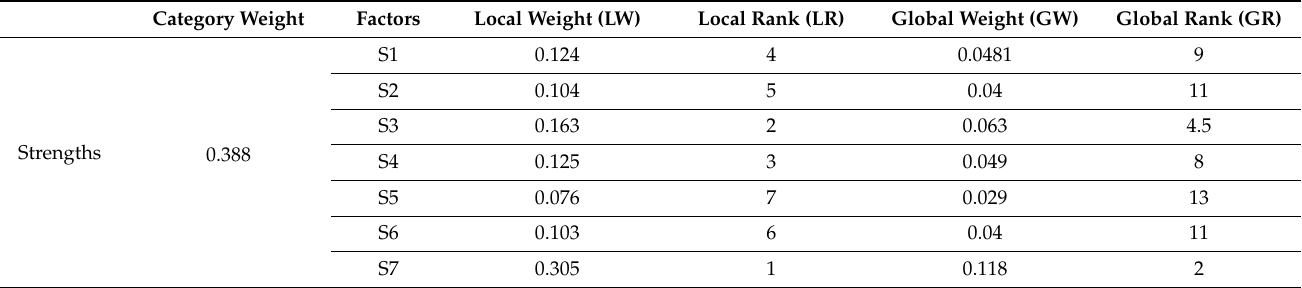
Table 14. Details of global and local weights of the factors and their SWOT